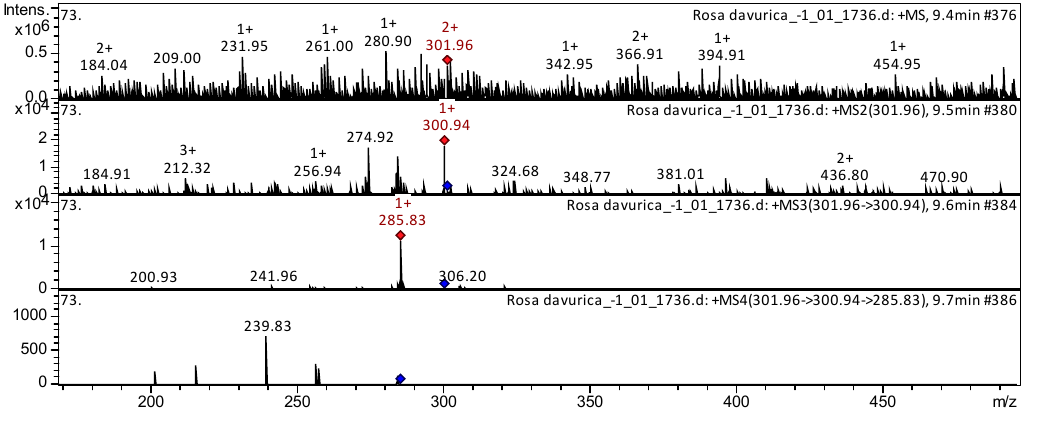
Figure 6. CID-spectrum of Isokaempferide from extracts of R. davurica , m / z 301.96. The [M + H] + ion produced five fragment ions at m / z 300, m / z 274, m / z 256, m / z 212, and m / z 184 (Figure 6). The fragment ion with m / z 300 yielded three daughter ions at m / z 285, m / z 241, and m / z 200. The fragment ion with m / z 285 yielded one daughter ion at m / z 239. It was identified in the bibliography in extracts of Rosa rugosa [30] and Propolis